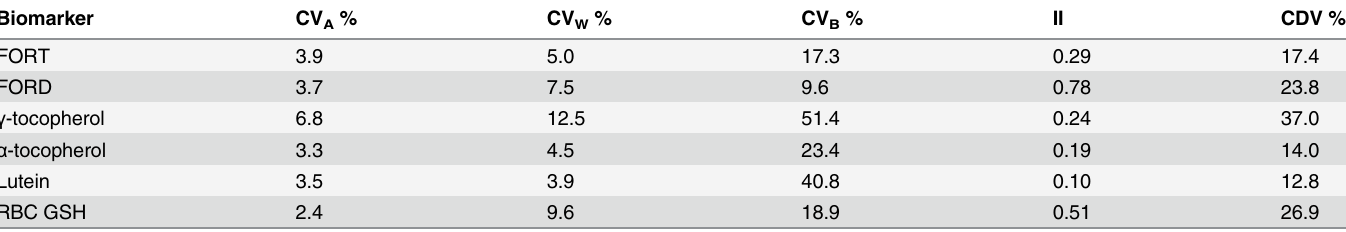
Table 2. Analytical and biological variation, critical difference values and index of individuality for FORT, FORD, RBC GSH, lutein, and α and γ - tocopherols. Biomarker